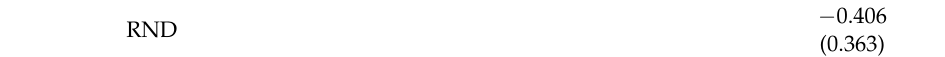
Robust standard errors in parentheses, clustered at the firm level. All regressions include firm fixed effects and